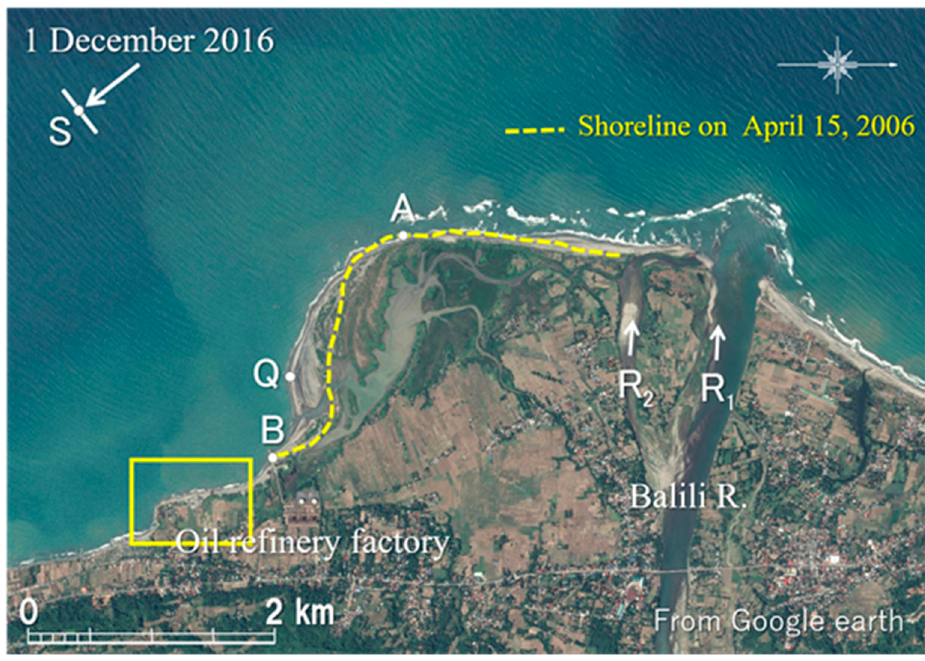
Figure 7. Satellite image of shoreline around Balili River mouth (1 December 2016). The village of Bauang, La Union south of B, indicated by a rectangular area in Figure 7, is shown in Figure 8.